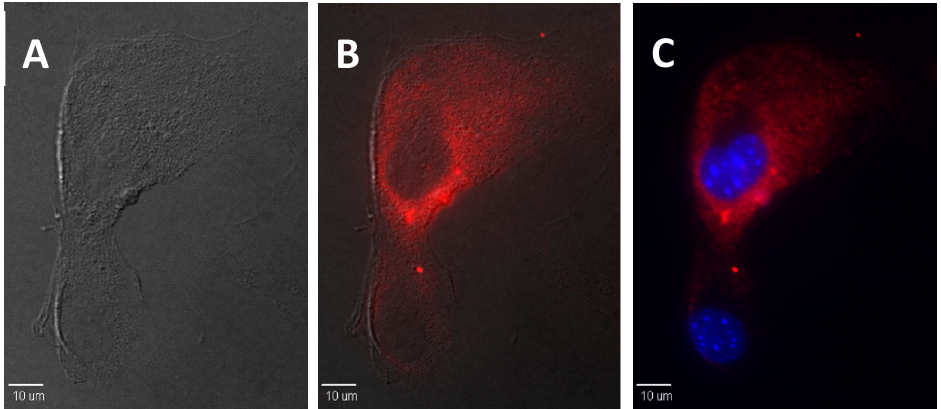
Figure 4. 3T3 cells were incubated with dU-BZ (15 μ M, 30 min). DIC image ( A ) indicates healthy morphology of 3T3 cells. Overlay image of dU-BZ fluorescence and DIC ( B ) indicates effective uptake of dU-BZ (Texas Red filter cube (Ex 562/40 nm, DM 593 nm, Em 624/40 nm). ( C ) shows overlay image of Hoechst (blue filter cube, Ex 377/50 nm, DM 409 nm, Em 460/50 nm), and dU-BZ fluorescence. Scale bar is 10 μ m.